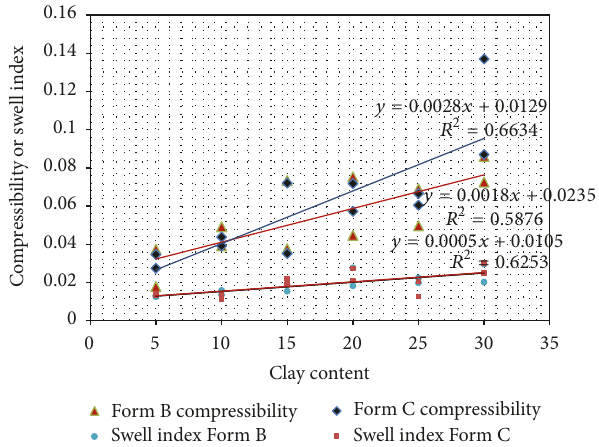
Figure 11: Compressibility and swell index for all tested clay